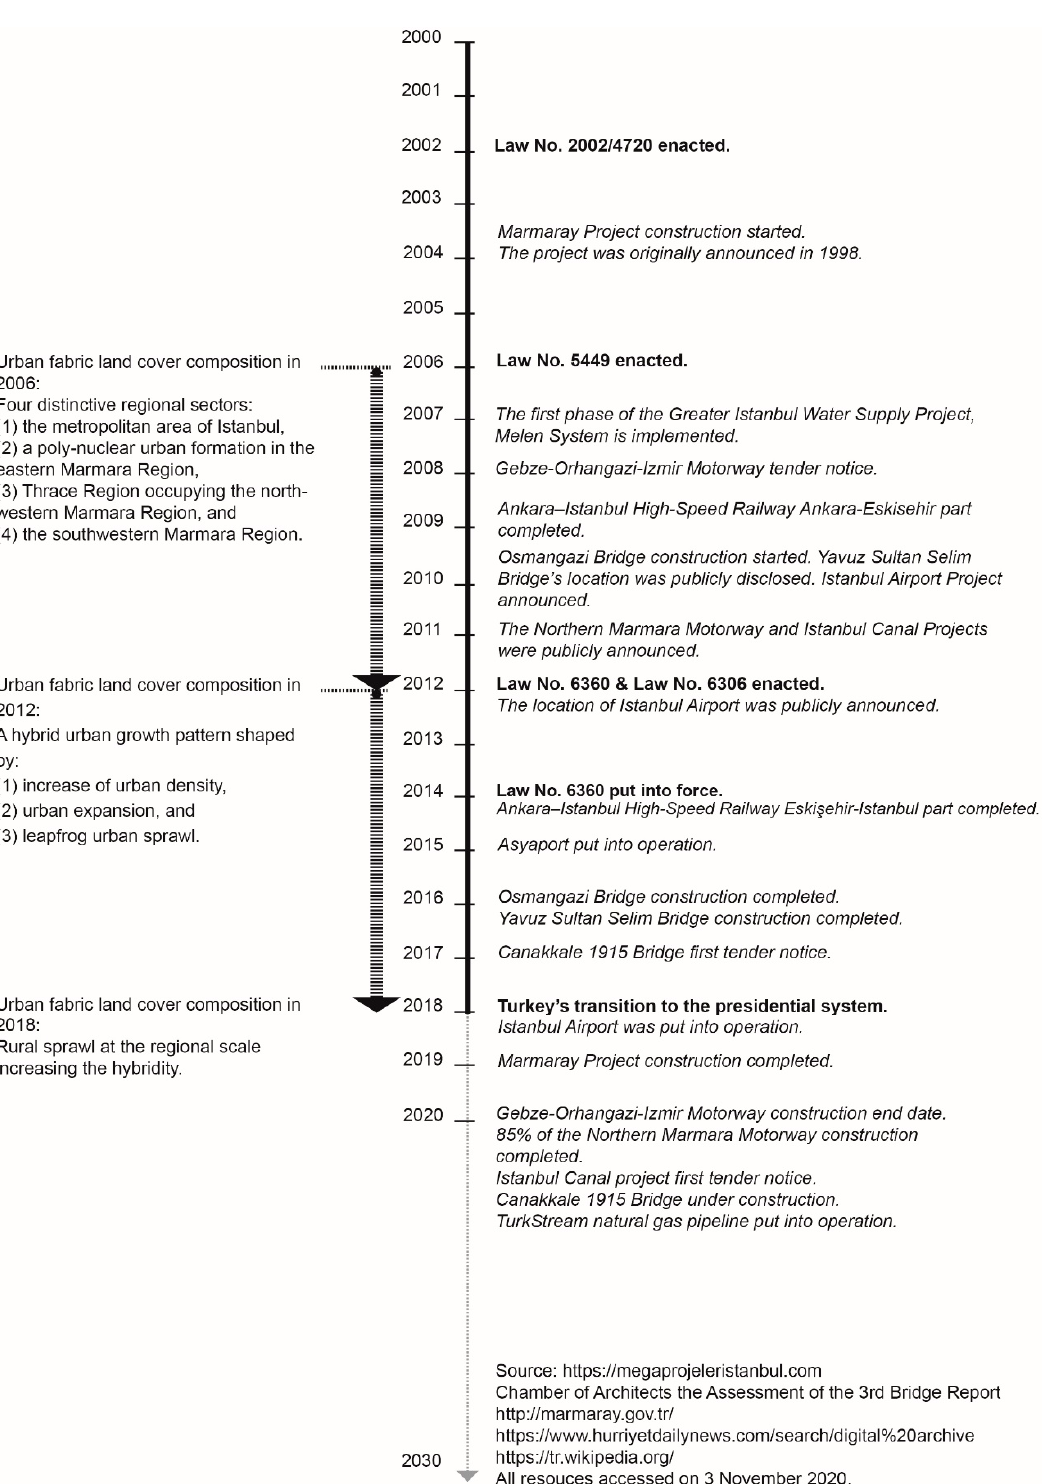
Figure A1. Timeline.